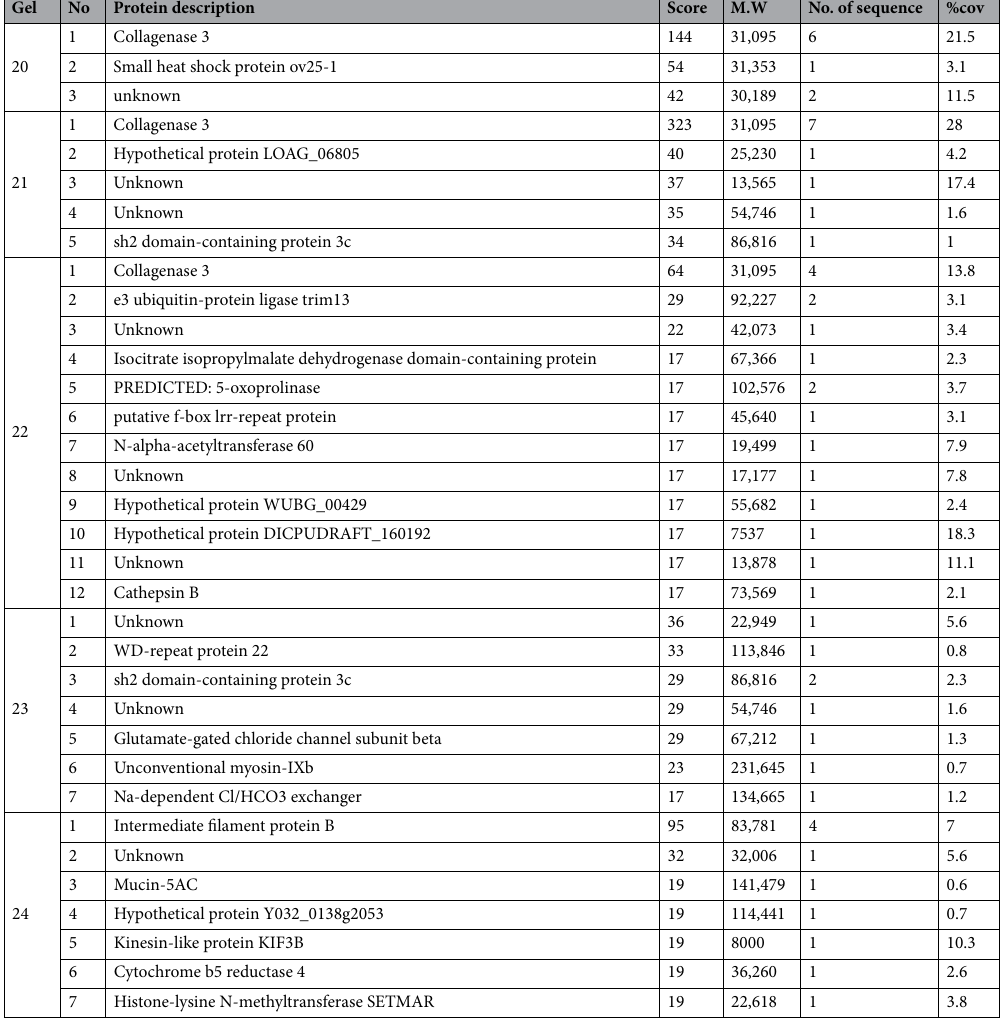
Table 5. List of proteins identified from aL3Gs after 2D-immunoblot analysis to identify proteins of importance related to diagnostic development of gnathostomiasis